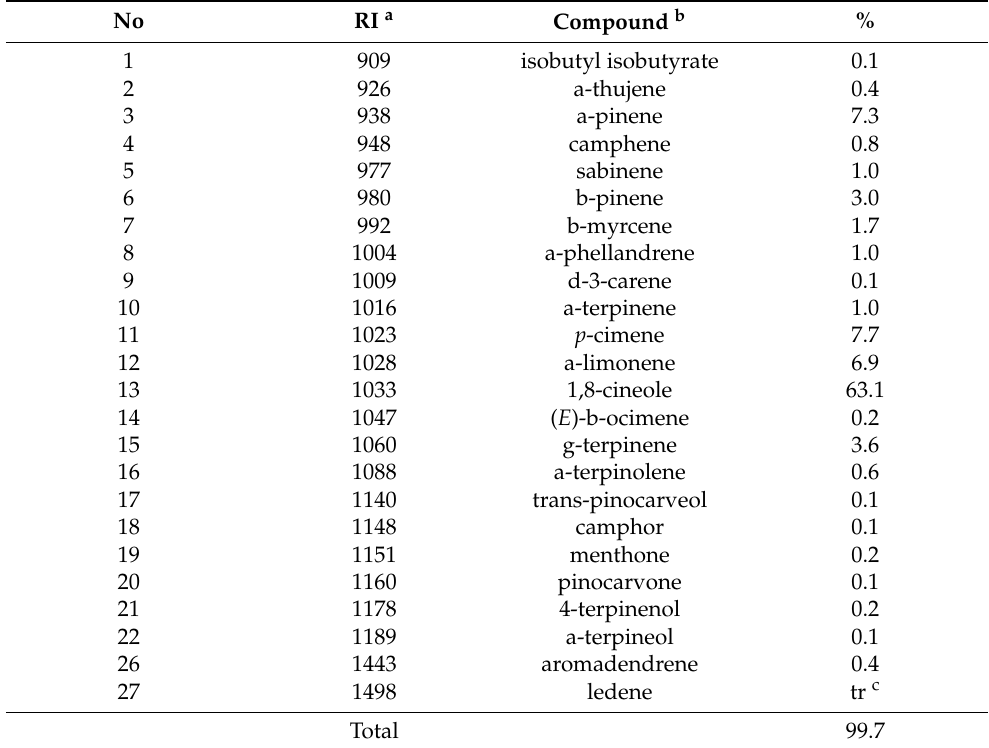
Table 1. Chemical Composition of Eucalyptus globulus Essential Oil.